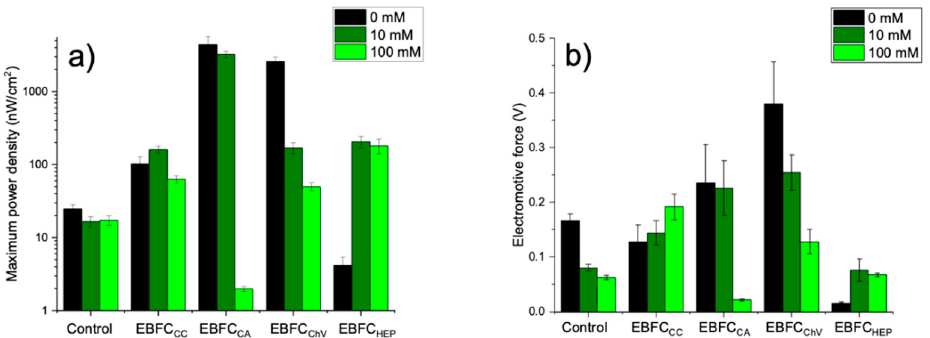
Figure 3. Dependences at different glucose concentrations of ( a ) the electric power; ( b ) the electromotive force of0 control of the study; EBFC CC ; EBFC CA ; EBFC ChV ; EBFC Hep .